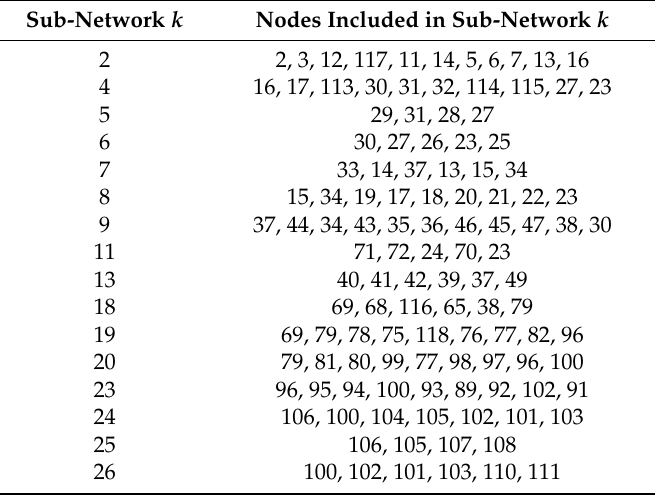
Table 1. Partial sub-networks and their nodes.